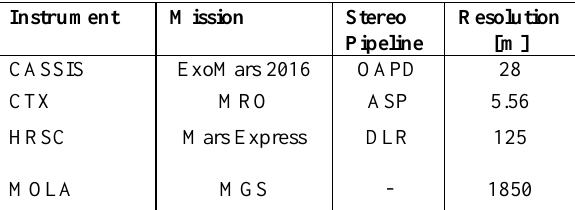
Table 3. DTM instrument sources taken in account for the analysis of the same CaSSIS region.